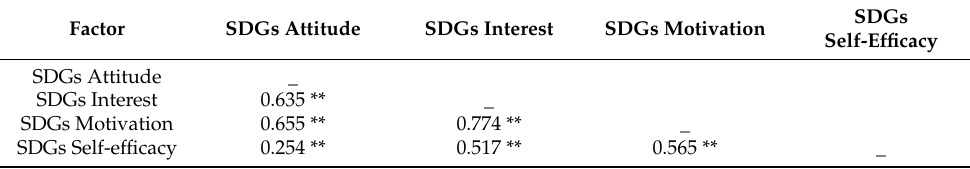
Table 6. Matrix of intercorrelations among